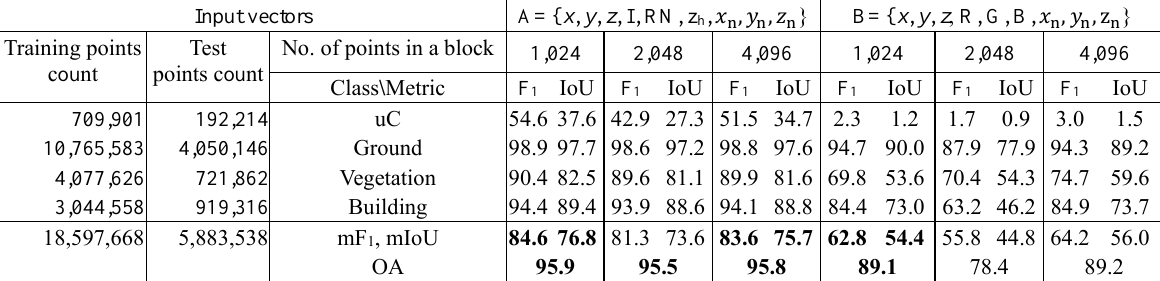
Table 4 . PointNet performance for the Dudelange test dataset (values are in